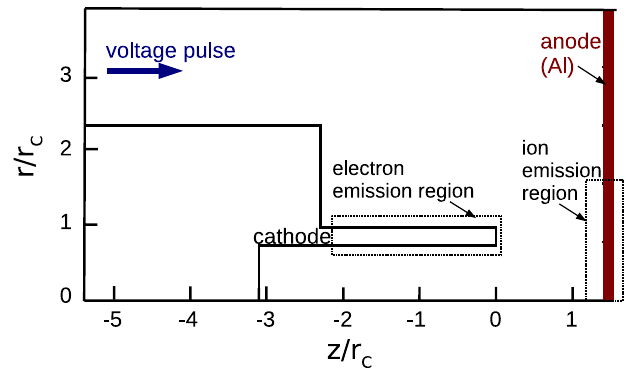
FIG. 3. The simulation geometry of the SMP diode. The forward-going voltage wave is injected at the upper left. The region of electron SCL emission is outlined on the cathode. Desorption of the anode plasma occurs in the region outlined on the